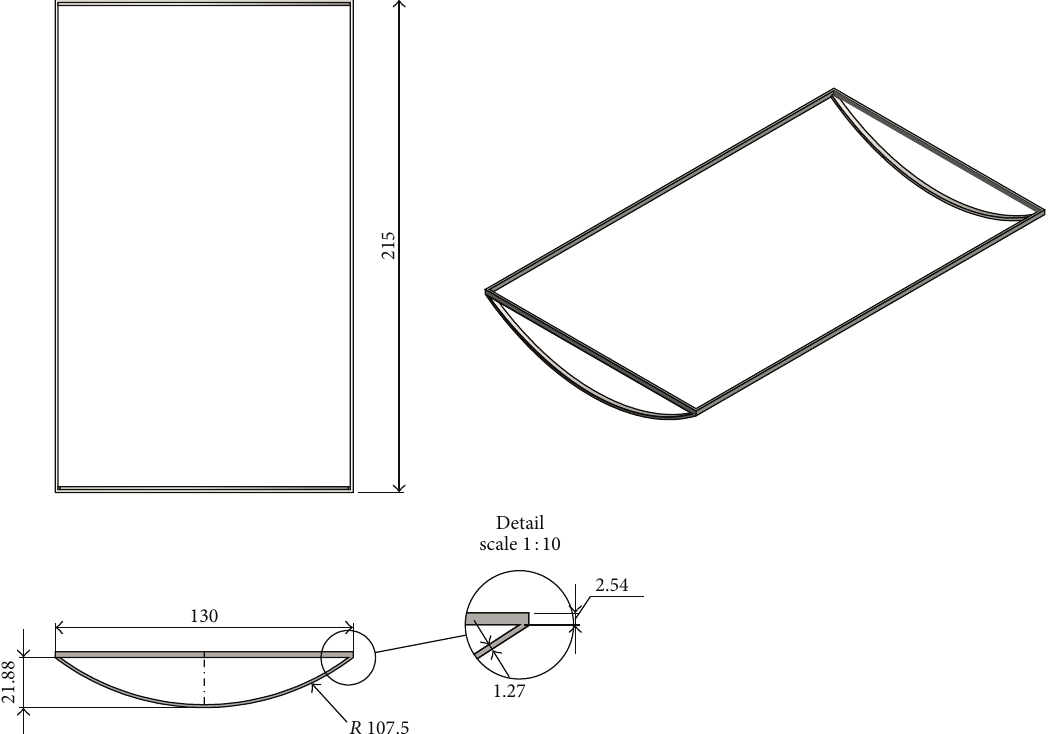
Figure 1: Design of the structure of the cylindrical concentrator.